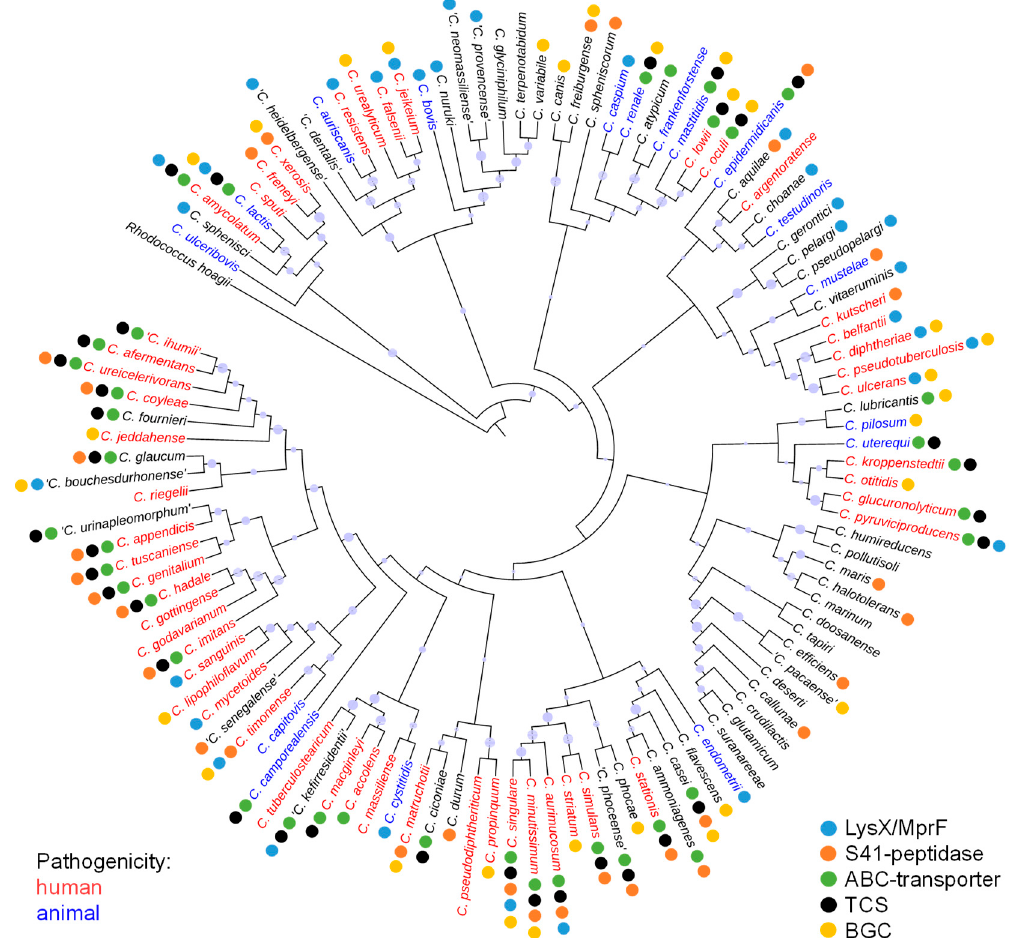
Figure 1. Phylogenetic arrangement of 114 Corynebacterium species investigated in this study. The predictions of resistance traits and bacteriocin gene clusters are indicated by colored dots behind the species name. Species that are described to be human pathogens are written in red letters, those that are animal pathogens are written in blue letters. Non-pathogenic species are depicted in black letters. Species with names that are not validly published are indicated by quotation marks. TCS = two-component system; BGC = bacteriocin gene cluster.